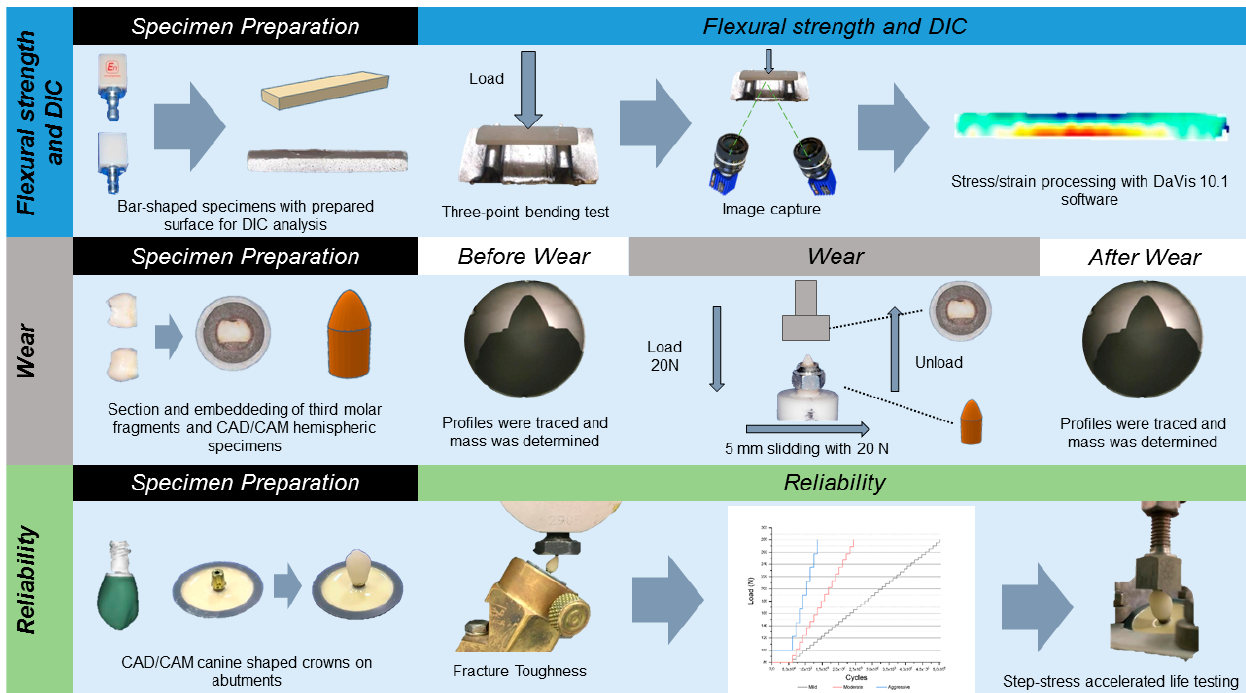
Figure 1. Experimental design representing the workflow adopted for the performed analyses.